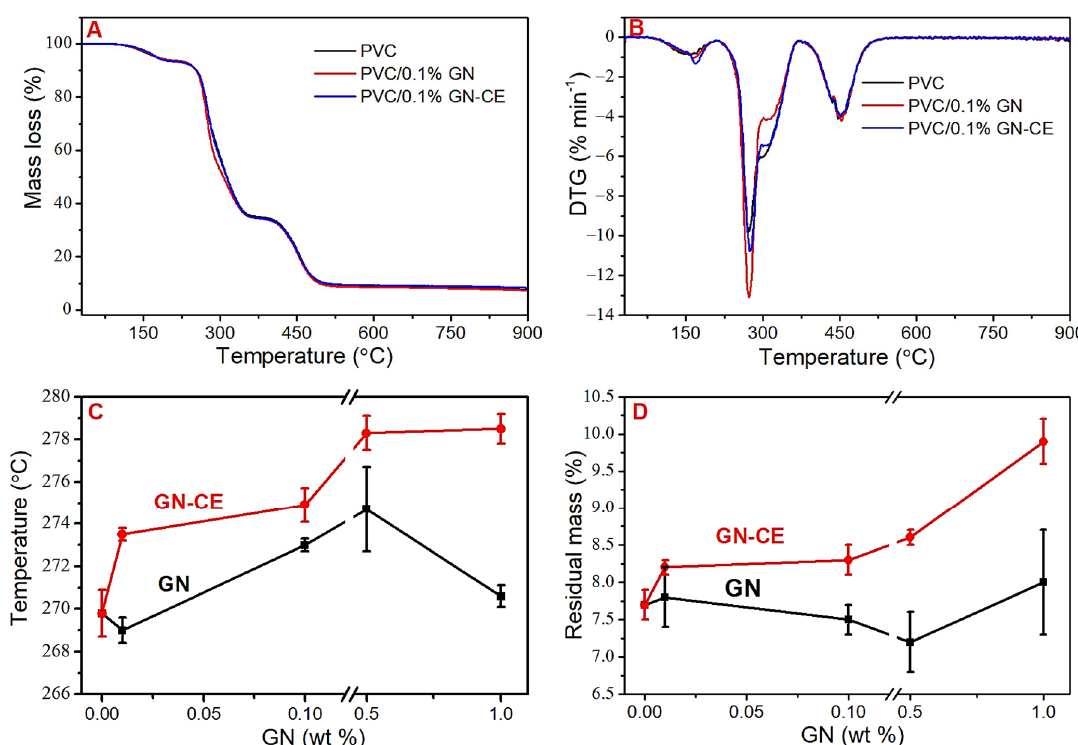
Figure 11. ( A ) Example TGA thermograms, ( B ) Example DTG curves, ( C ) Max. DTG I analysis, ( D ) Residual mass analysis.